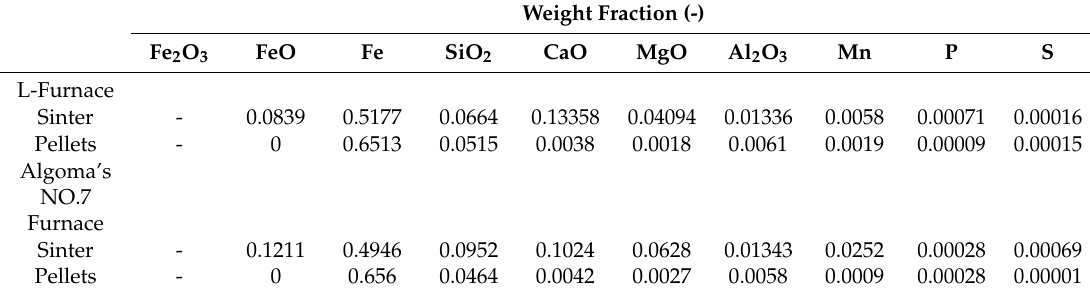
Table 4. Chemical composition of iron